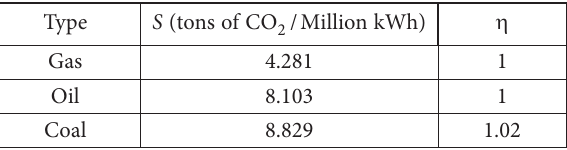
Table 1. Coefficients for different fuels